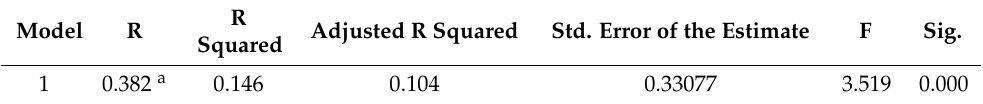
Table 4. Model summary (financial